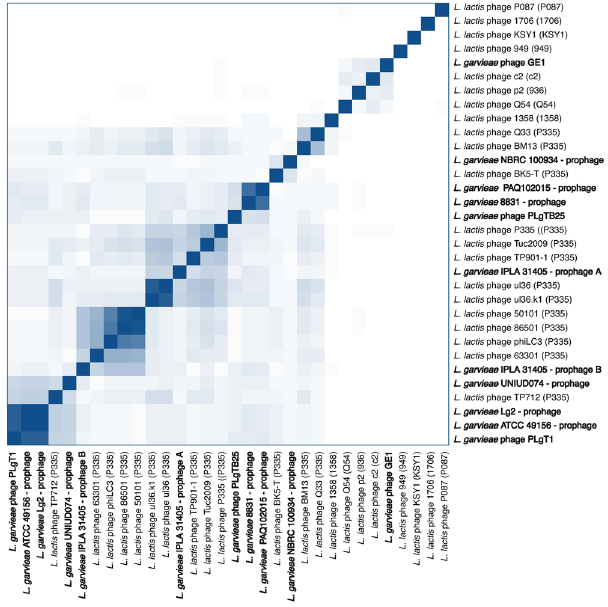
Figure 3. Similarity matrix of 32 lactococcal phages and prophages based on the presence/absence of genes. The heatmap is generated based on the number of proteins shared by phages. Deeper shade of blue indicates a closer